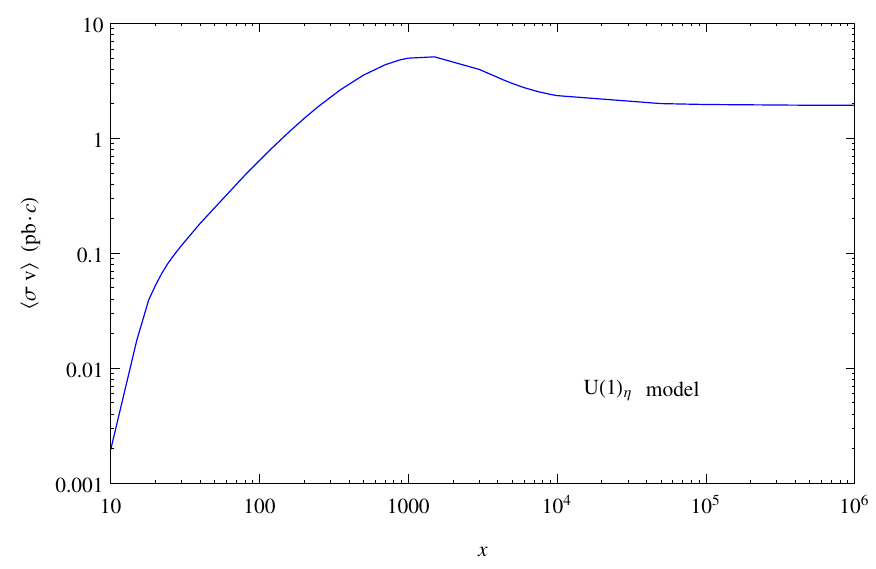
Figure 6. Thermally averaged cross section as a function of the scaled inverse temperature x M ~ (cid:23) =T for the parameters of the U(1) (cid:17) model that saturate the upper bound on the sneutrino R; 1 mass. Nominal decoupling occurs at x = x F = 27 : 2, whereas in today’s galaxies x